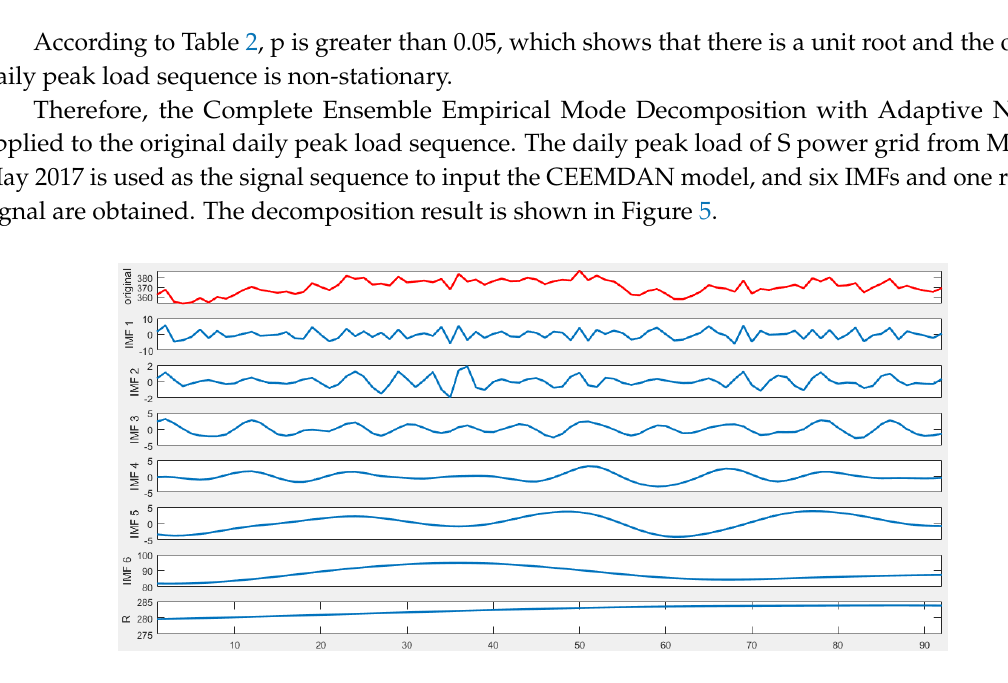
Table 2. The unit root test result.